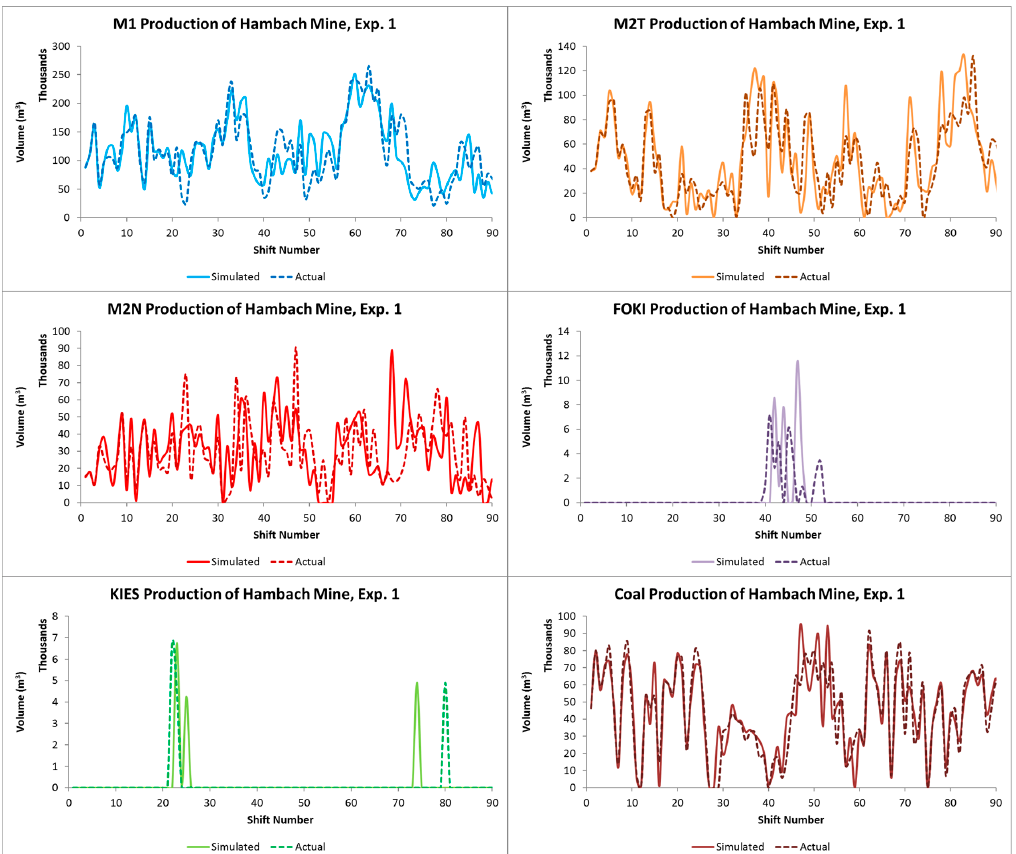
Figure 20. The shift-based production of different materials of the Hambach mine, Experiment 1.